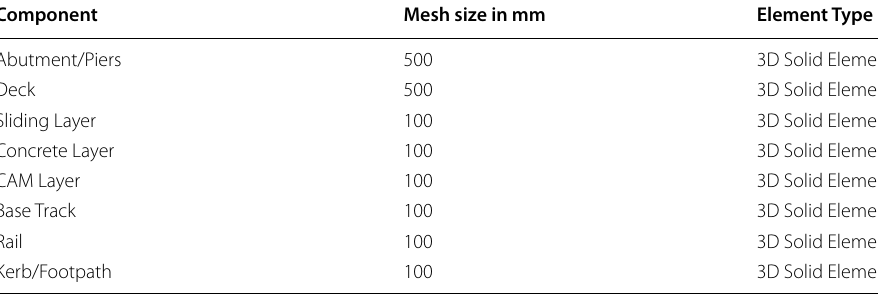
Table 4 Mesh size and element type of component Component Abutment/Piers